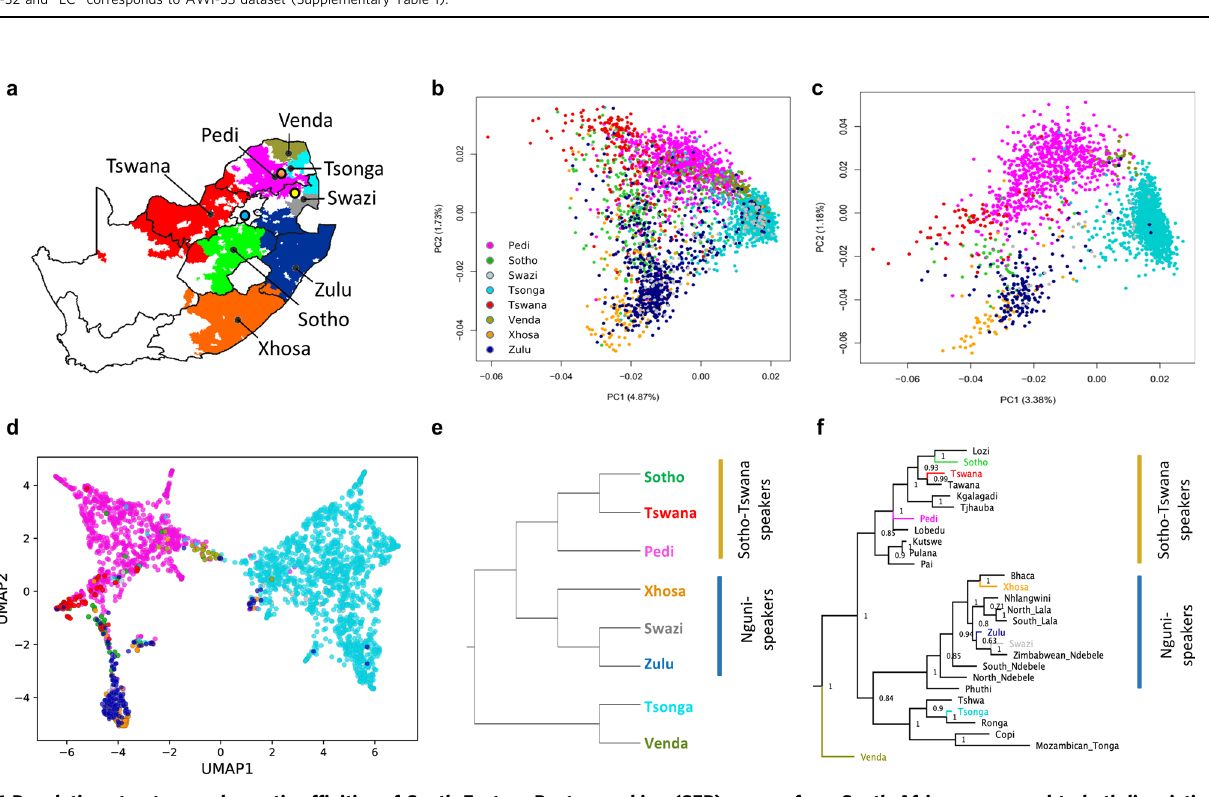
The three columns for each centre shows: the total number of samples (All), the number of unrelated samples (PIHAT< 0.18) (UR) and the ethno-linguistically concordant (EC) samples (self-reported ethno-linguistic identity of a participant is same as the ethno-linguistic identity of at least fi ve of the six parents and grandparents). The column “ All ” corresponds to the AWI-S1, “ UR ” corresponds to AWI-S2 and “ EC ” corresponds to AWI-S3 dataset (Supplementary Table 1).